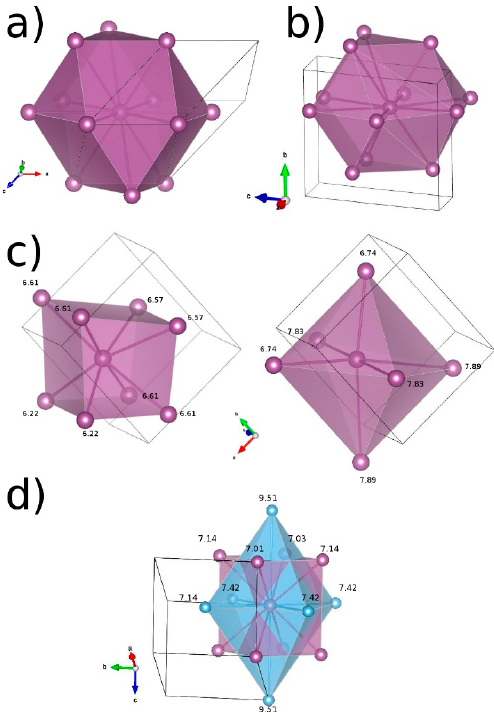
Figure 2. Anion–anion coordination for ( a ) monoclinic rt -Na 2 B 12 H 12 with cubic close packing ( ccp ) of anions. The first coordination sphere contains 12 nearest neighbors at the distance 7.01–7.42 Å forming a cuboctahedron; ( b ) monoclinic rt -K 2 B 10 H 10 with hexagonal close packing ( hcp ) of anions. The first coordination sphere forms an anti-cuboctahedron with a bond distance 6.67–7.68 Å; ( c ) orthorhombic rt -NaCB 9 H 10 with body-centered cubic ( bcc ) packing of anions. The first coordination shell is shown on the left, while the second shell is shown on the right (cube and octahedron, respectively). ( d ) Wrong determination of coordination polyhedron for the rt -Na 2 B 12 H 12 leading to the false determination of a bcc sublattice. The apical atoms in the octahedron are indeed at the distance of 9.51 Å, while all the others fall in the range 7.0–7.4